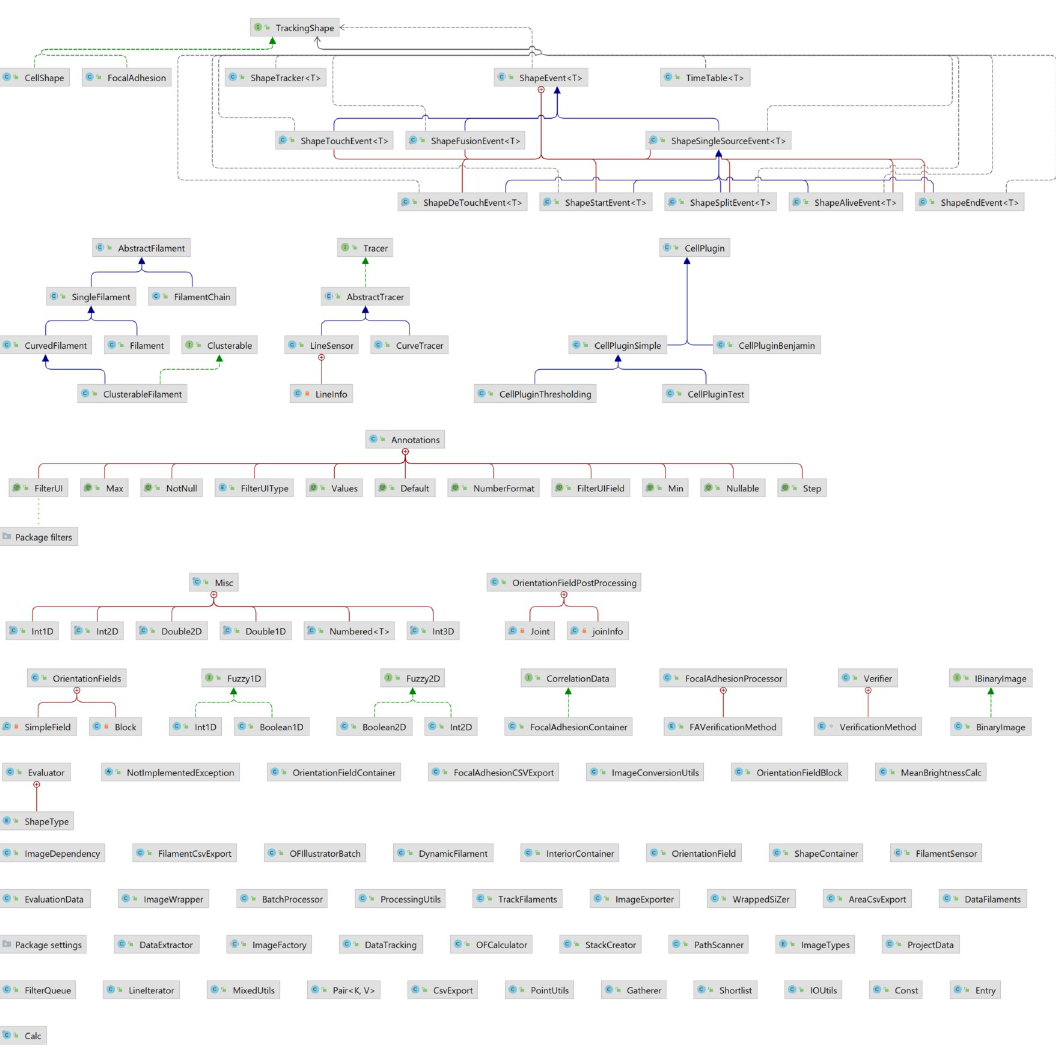
Fig 6. Class tree of the main FS sources. Reduced class tree of classes necessary for fiber tracking and annotation. Wherever possible dependencies are avoided, thus main classes like DynamicFilament , which is used for single filament tracking, can be reused easily.